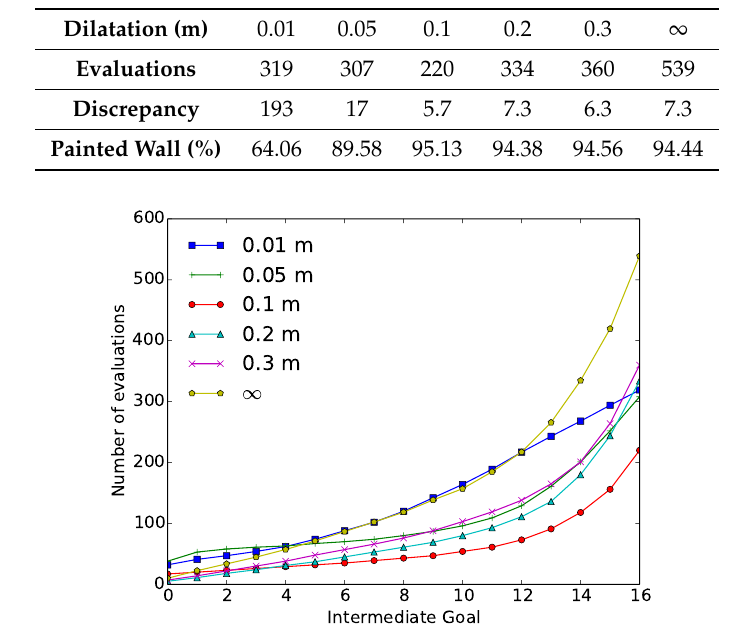
Table 5. “Paint” geometrical constraint experiment results.